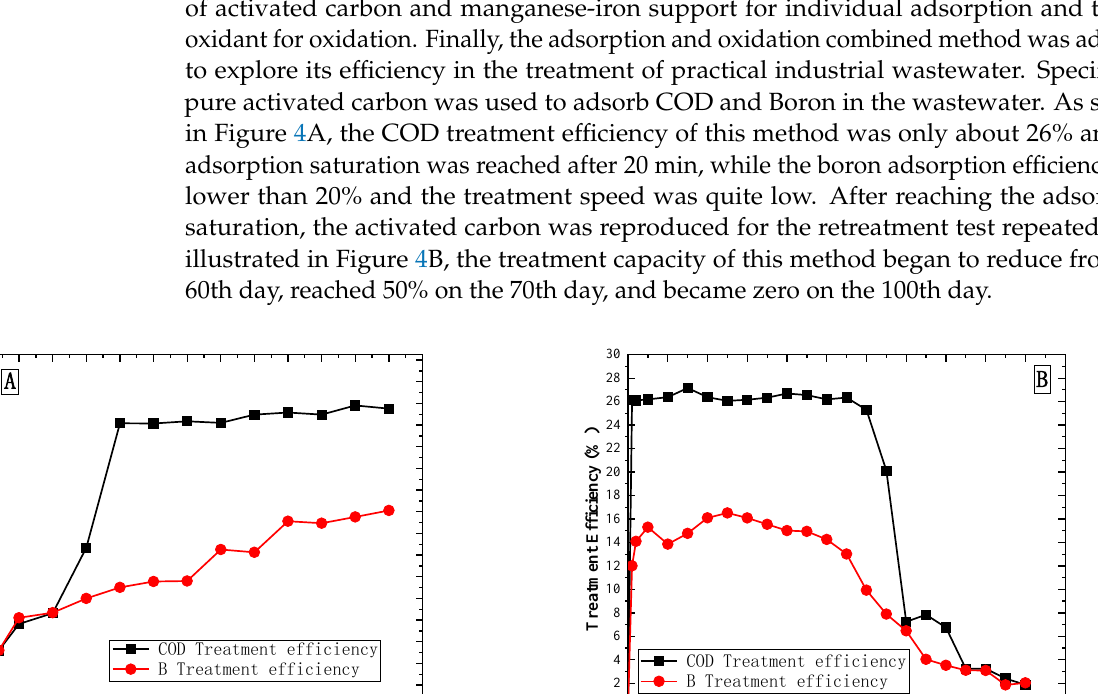
Time (mins) COD Treatment efficiency B Treatment efficiency Figure 5. The adsorption treatment efficiency curve of manganese dioxide/iron oxide support (without oxidant). In order to clearly observe the treatment efficiency of the manganese-iron support and activated carbon combined method, experiments were done on the manganese-iron support with or without activated carbon respectively. As a result (Figure 6A), the COD